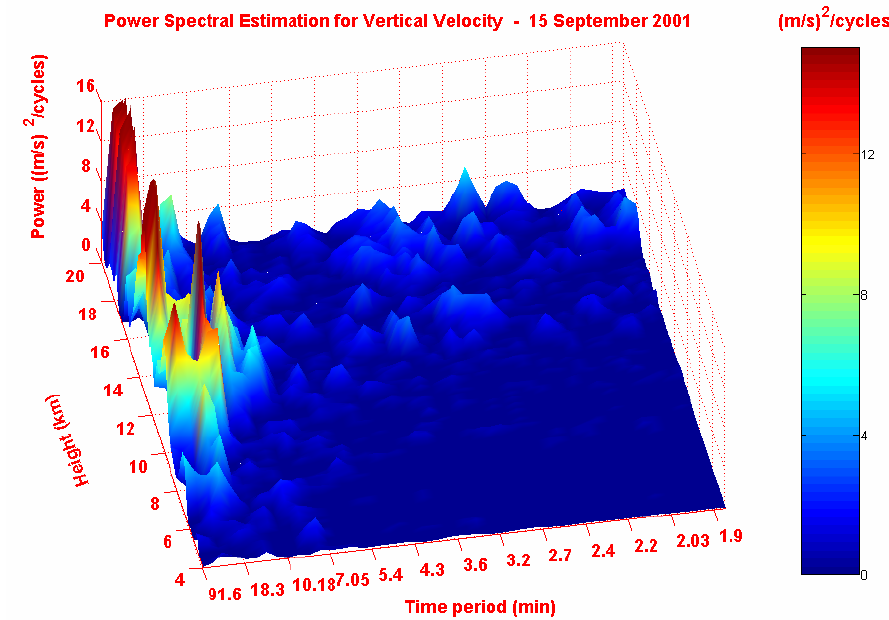
Fig. 11. Shows the frequency-power spectral estimation for vertical velocity on 15 September 2001 during the convection event observed for